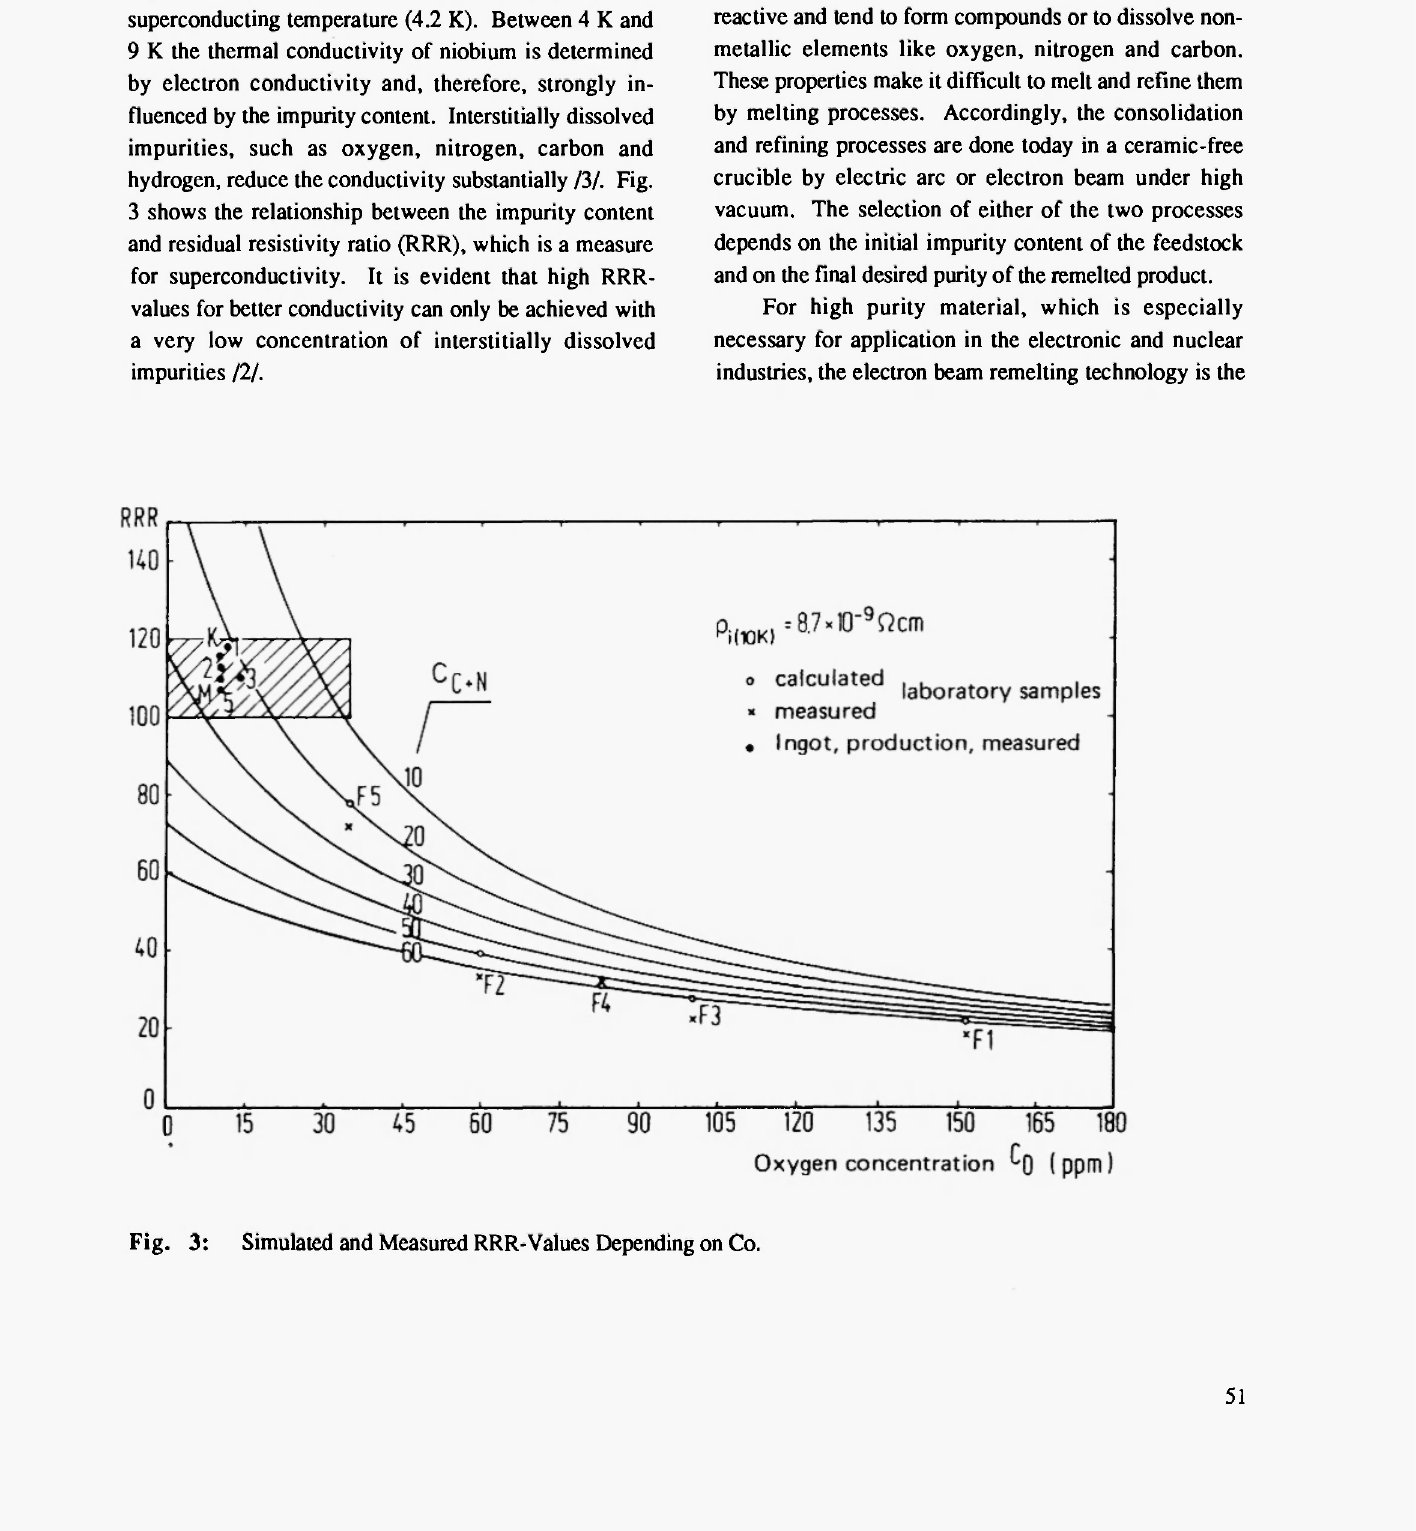
Fig. 3: Simulated and Measured RRR-Values Depending on